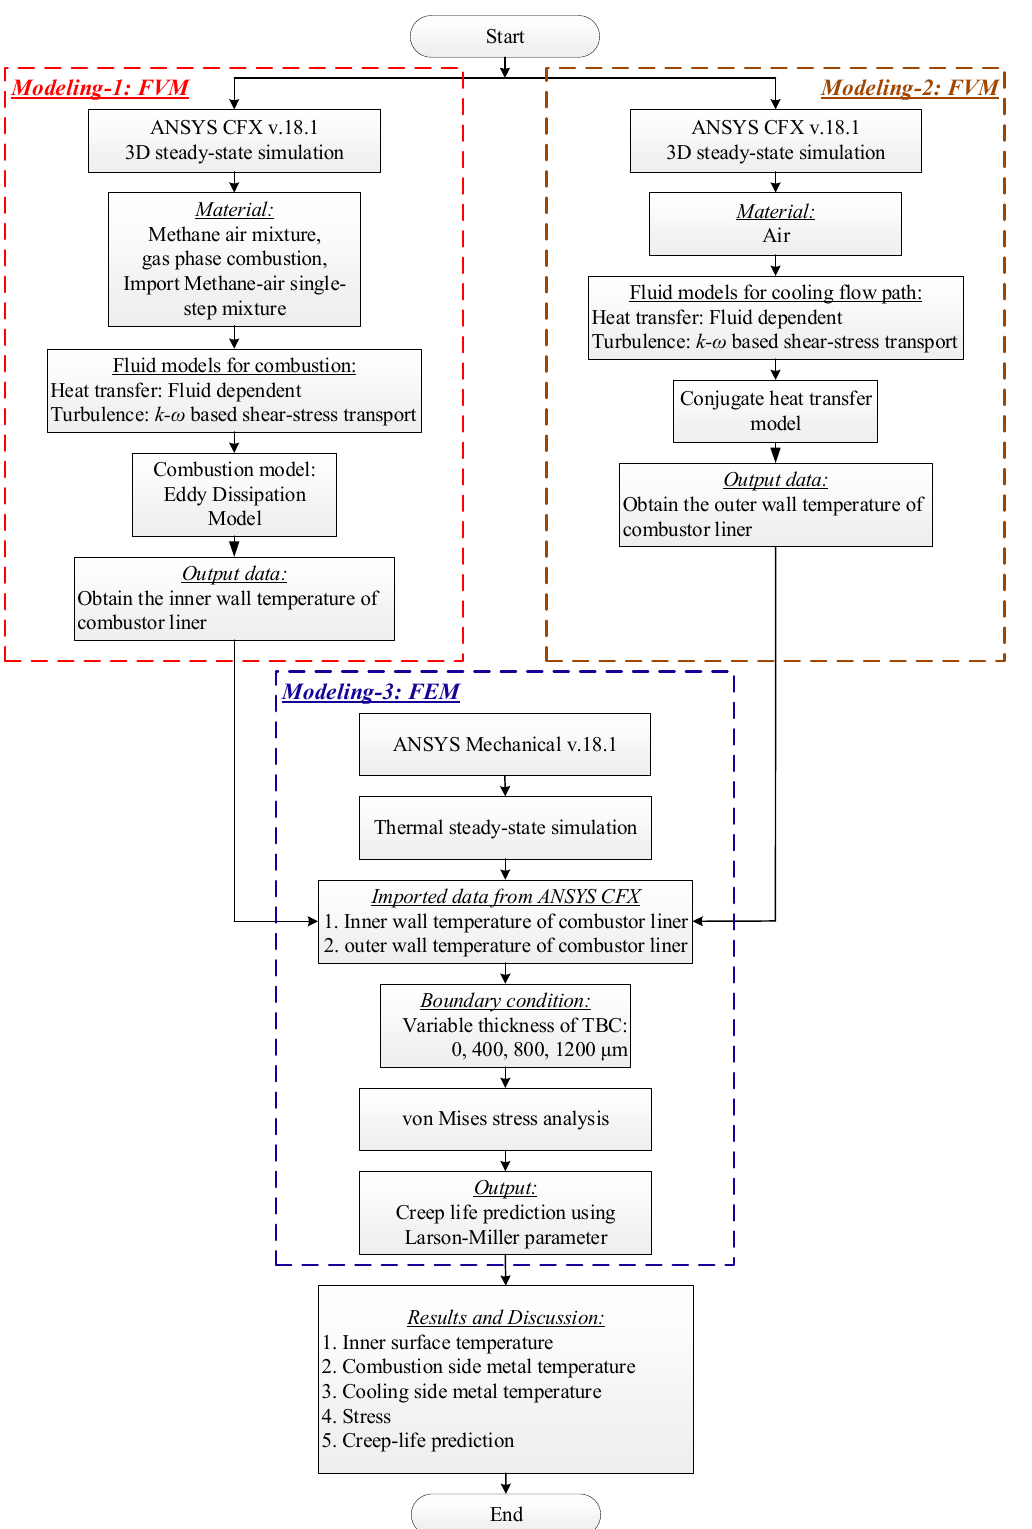
Figure 3. Flow chart that shows how the three simulations were carried out in the present work.